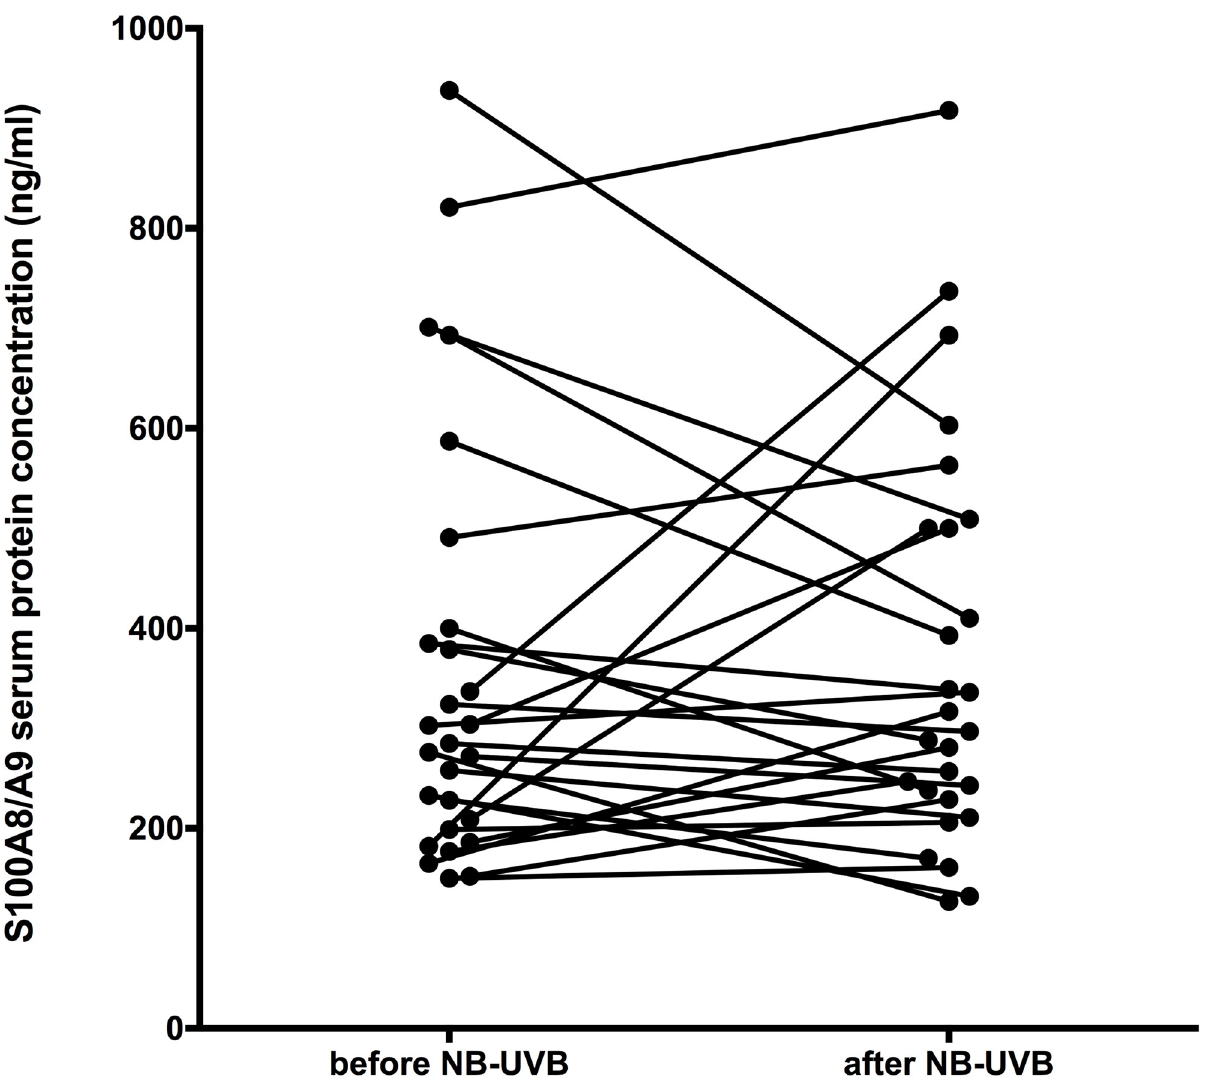
Fig 5. Serum S100A8/A9 levels before and after completion of NB-UVB psoriasis treatment. No significant difference was found (n = 27).